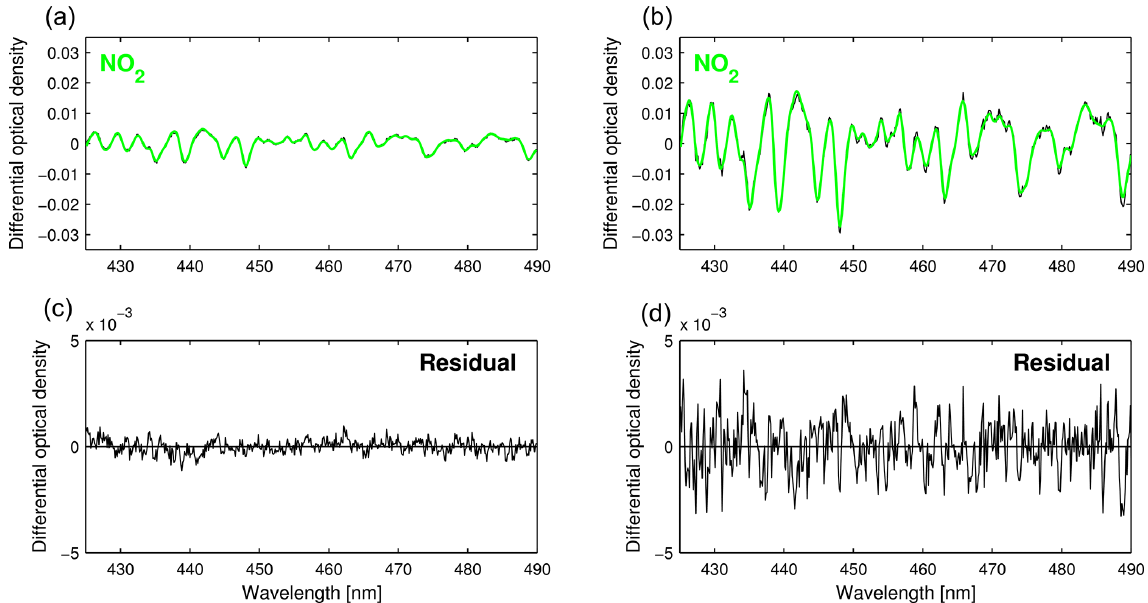
Figure 3. Exemplary fit results from the DOAS analysis in the 425–490nm fitting window for a car DOAS spectrum (a, c) , as measured on 10 April 2015 (SZA = 47.68 ◦ , DSCD = 4 . 03 × 10 16 molcm − 2 ) and averaged over intervals of 5s as well as exemplary fit results for a tower DOAS spectrum (b, d) , as measured on 29 April 2016 (SZA = 66.99 ◦ , DSCD = 1 . 46 × 10 17 molcm − 2 ) and averaged over intervals of